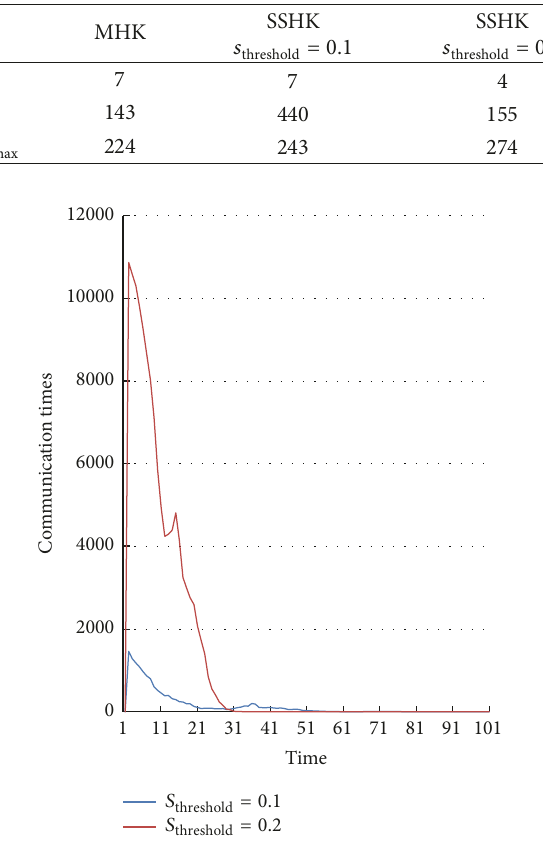
Figure 6: Communication times of agents outside the confidence bound in the SSHK model with 𝑠